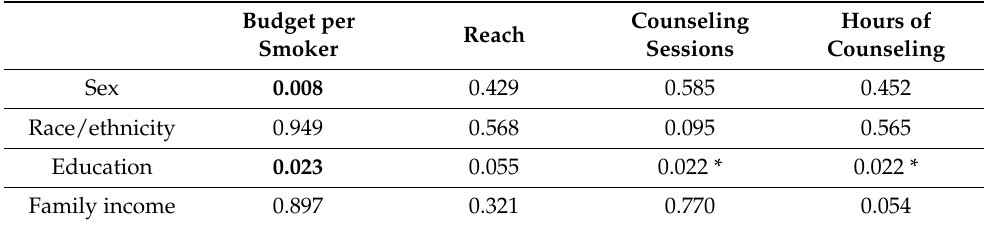
0.060.0650.070.0750.080.0850.090.0950.1